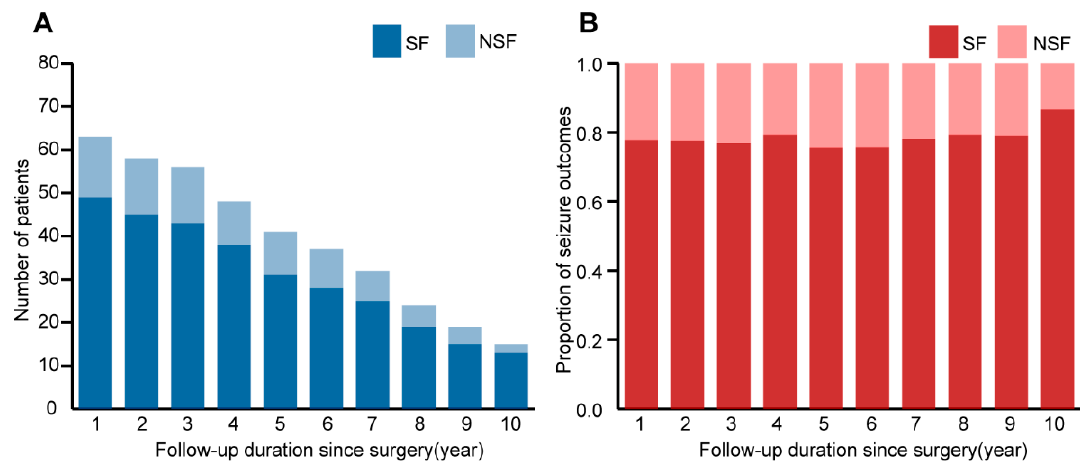
Figure 3. ( A ): Number of patients by seizure outcomes according to follow-up duration since sur- gery; ( B ): year-to-year analysis of seizure outcomes, the seizure-free rate remained basically